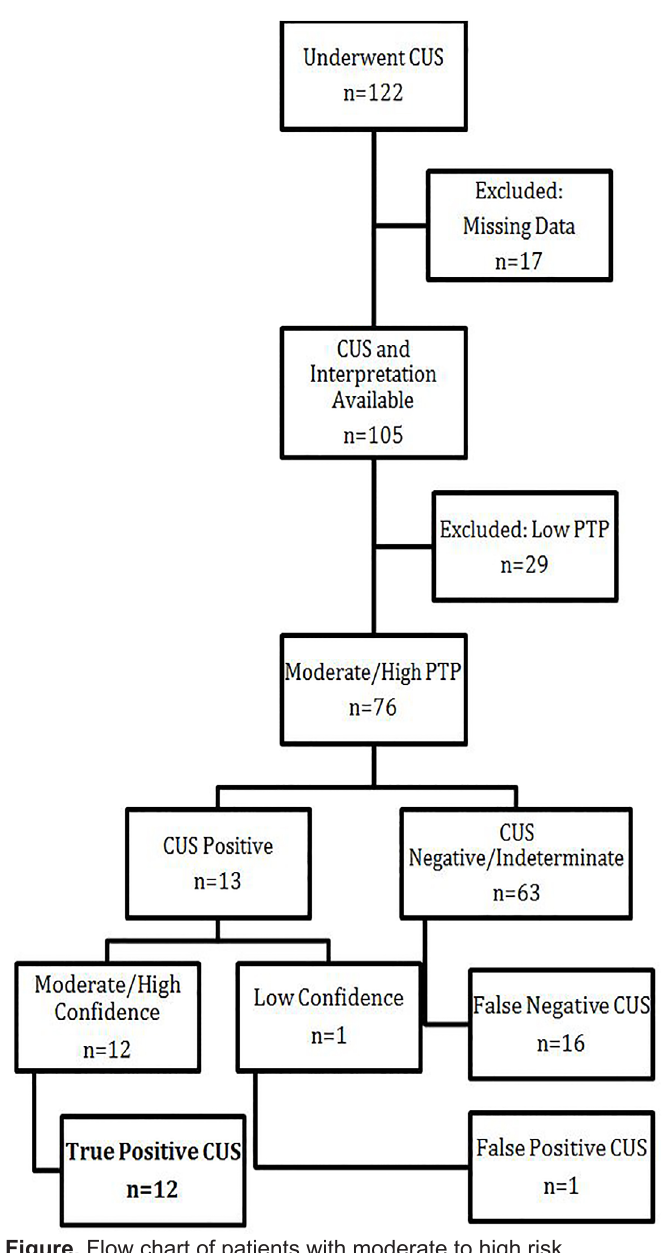
Figure. Flow chart of patients with moderate to high risk appendicitis and use of clinical ultrasound. Among patients with moderate to high risk of appendicitis, clinical ultrasound identified 12/28 cases of acute appendicitis. Among positive CUS scans, all tests with high sonographer confidence were true